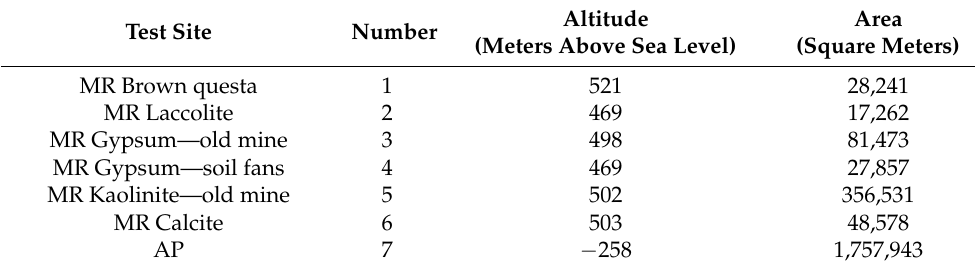
Table 1. Test site